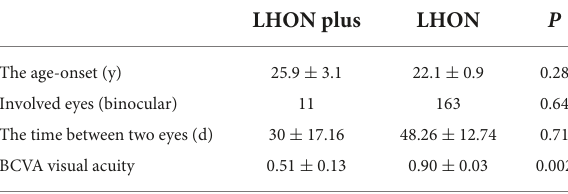
TABLE 2 The clinical characteristics between Leber’s hereditary optic neuropathy (LHON) with other diseases and pure LHON.